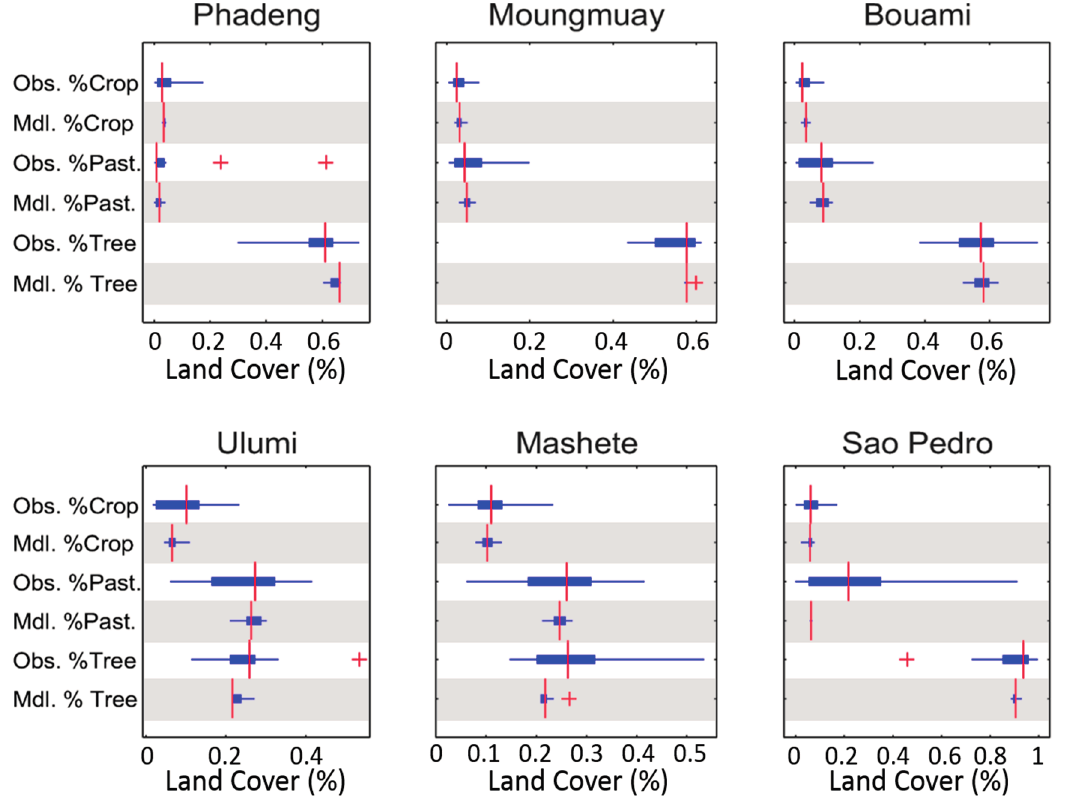
Figure 1. Site-specific observed (white bands) versus modeled (gray bands) percent land use/cover composition. Modeled land use/cover compositions fall within ranges observed from globally similar